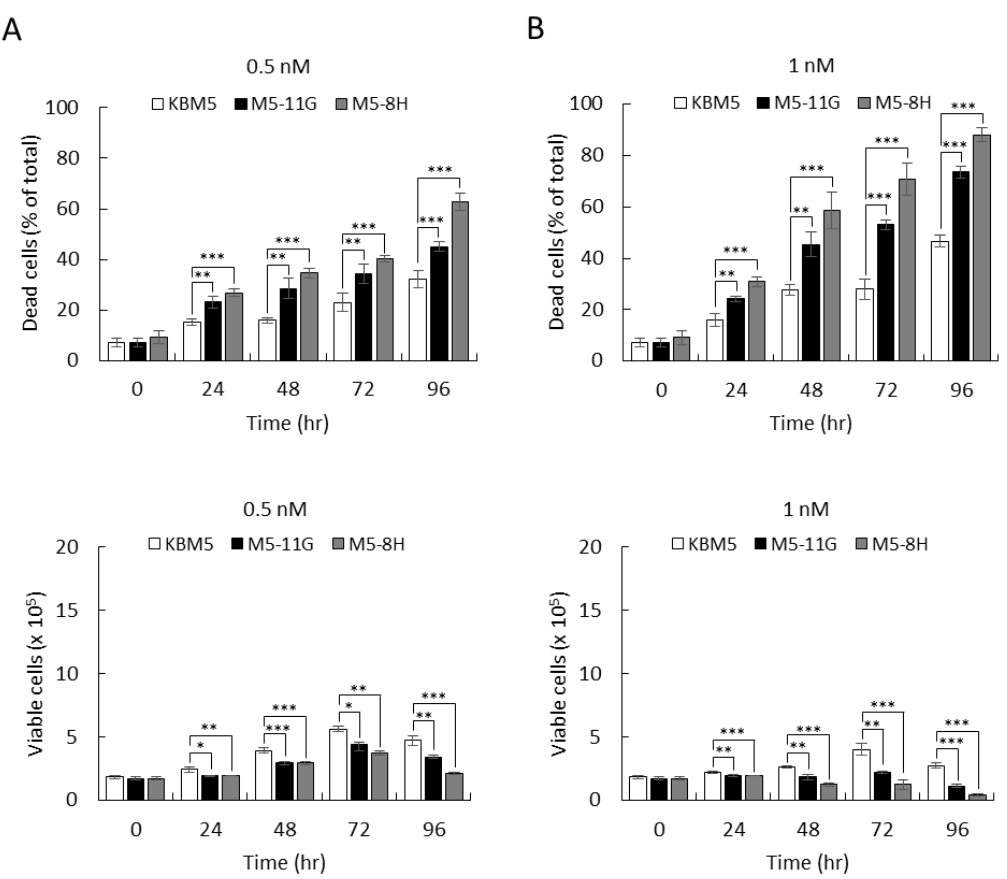
Figure 7. The p38 α deficiency increased cellular sensitivity to dasatinib in BCR-ABL-positive KBM5 leukemia cells. The KBM5 parental and p38 α -knockdown (M5-11G and M5-8H) cells were treated with 0.5 ( A ) or 1 nM ( B ) of second-generation TKI dasatinib. The viability of cells was examined by trypan blue exclusion. Knockdown of p38 α greatly enhanced the therapeutic efficacy of dasatinib. All results shown are representative of three independent experiments. Viable and dead cell numbers are presented as the mean ± SE of three repeats. * p < 0.05, ** p < 0.01, and *** p < 0.005.